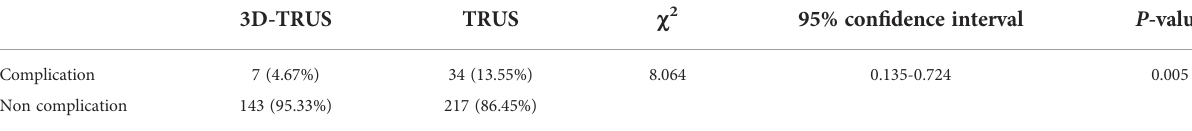
TABLE 9 Comparison of complications of biopsy session between 3D-TRUS and TRUS.